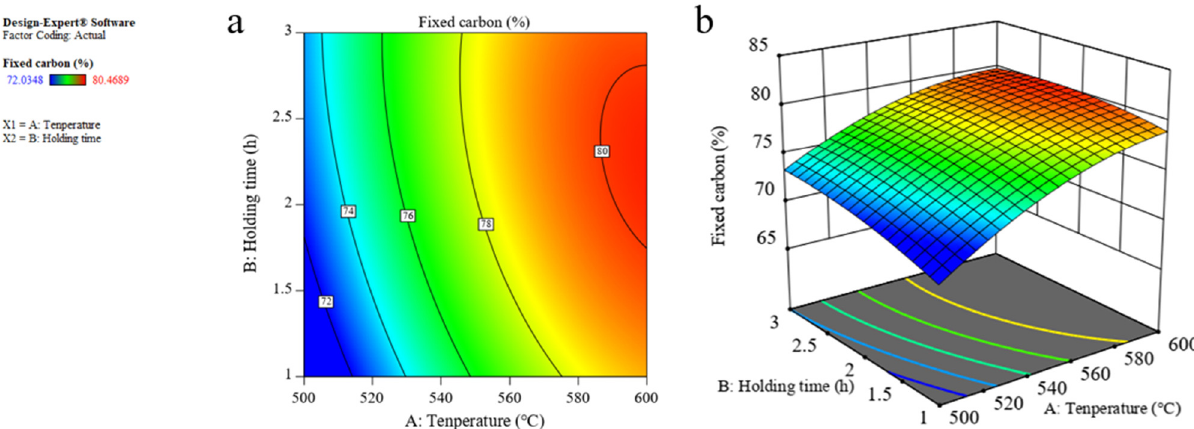
Figure 5: E ff ect of the interaction between temperature and holding time on fi xed carbon content. ( a ) Contour map of the e ff ect of temperature and holding time on fi xed carbon content. ( b ) Response surface plot of the e ff ect of temperature and holding time on fi xed carbon